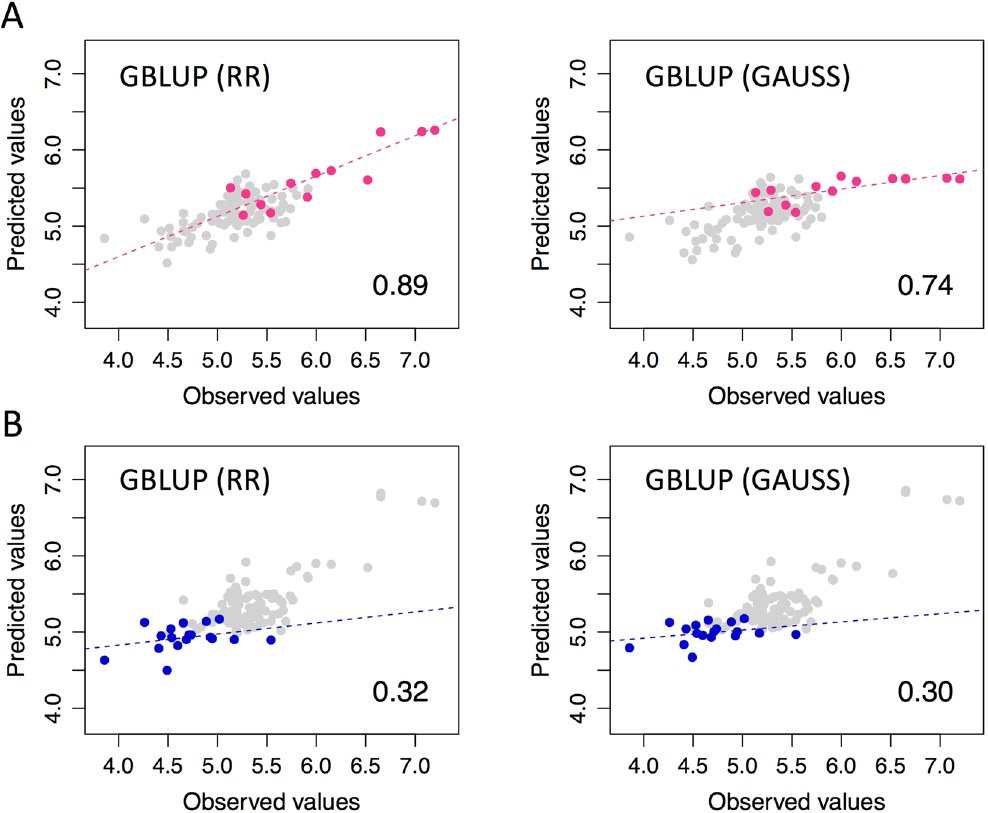
Figure 5. Prediction for fruit weight distribution tails. ( A ) All varieties except those in the large-fruit group (Fig. 2C), which is indicated by pink points, were used as the training set of the prediction model; the large-fruit group was used as the test set. ( B ) All varieties except those in the small-fruit group (Fig. 2C), which is indicated by blue points, were used as the training set; the small-fruit group was used as the test set. Grey points indicate the results of leave-one-out cross-validation. Predicted and observed values indicate log-transformed Weight. Pearson’s correlation coefficient ( r ) between predicted and observed values for the pink or blue points are shown on the plots. RR: linear ridge kernel regression, GAUSS: non-linear Gaussian kernel